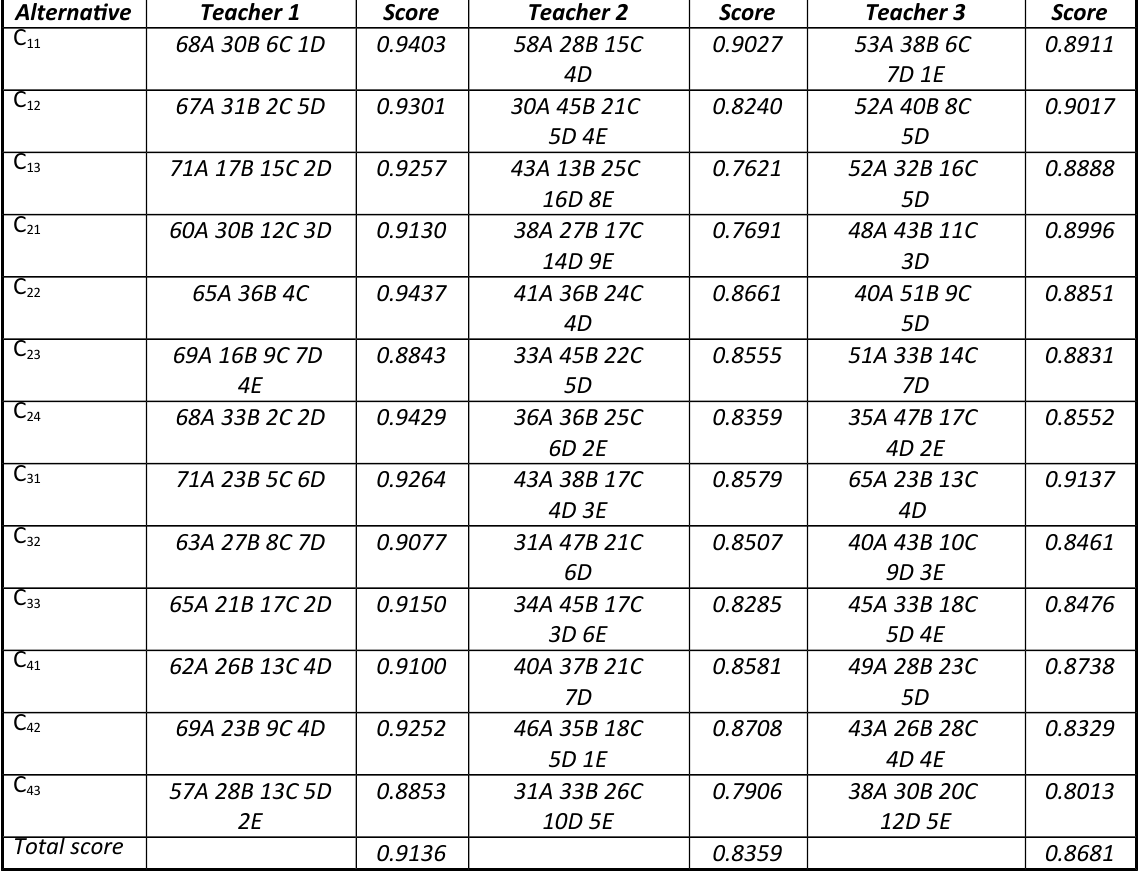
Table 10. Statistical data on experimental teaching